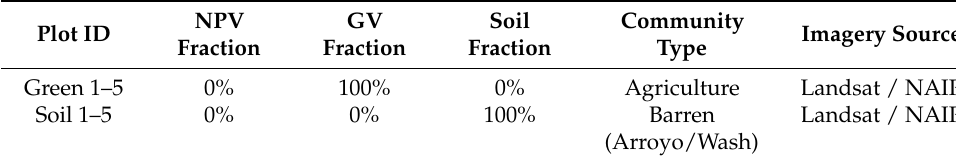
Table 3. Cover fractions of NPV, GV, and soil for all reference plots. Some rows may not sum to 100% due to